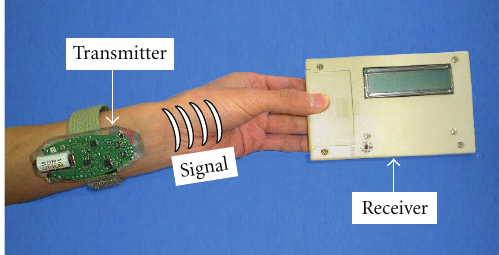
Figure 1: Transmission system using the human body as a transmission channel [8].